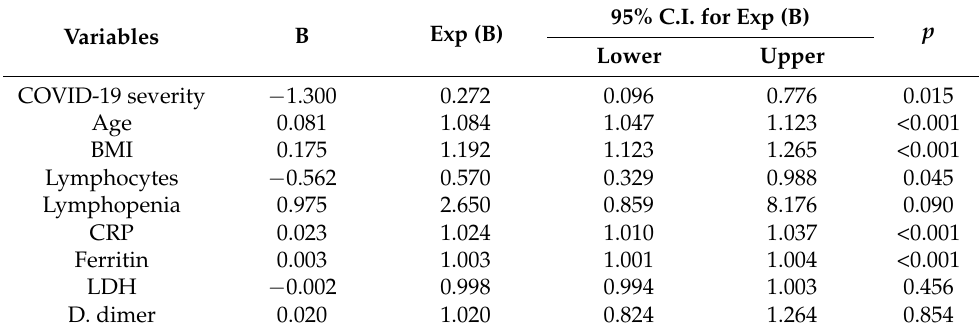
Table 4. Logistic regression analysis for predictors of presence of newly diagnosed DM among COVID-19 patients ( n =